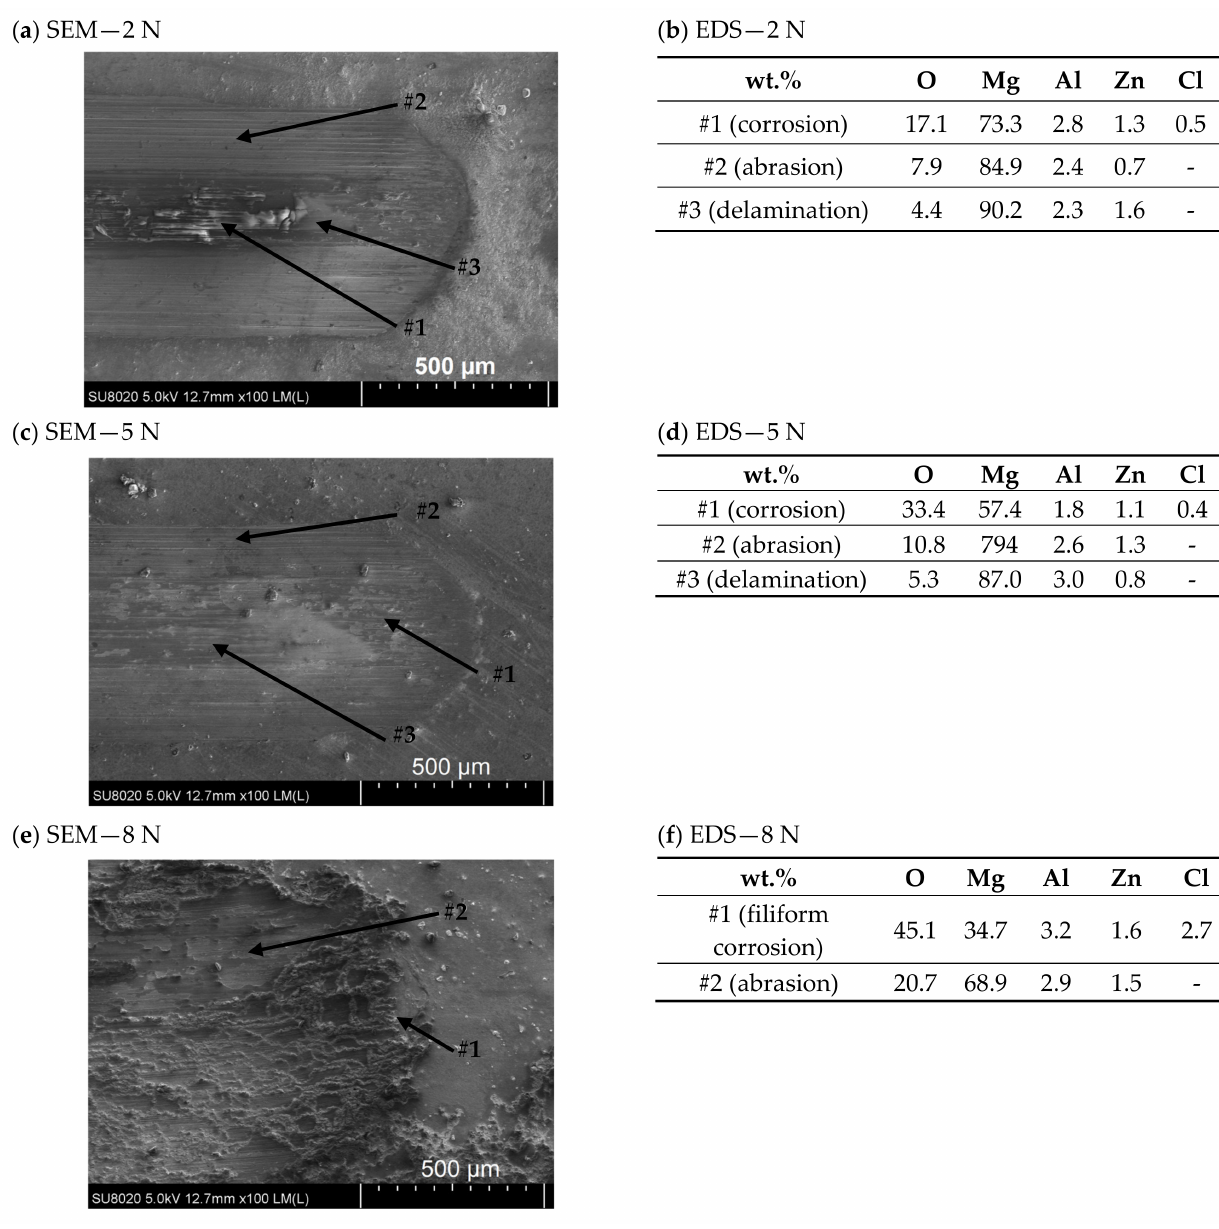
Figure 6. SEM and EDS analysis of AZ31 magnesium alloy in tribocorrosion: ( a ) SEM—2 N, ( b ) EDS— 2 N, ( c ) SEM—5 N, ( d ) EDS—5 N, ( e ) SEM—8 N, ( f ) EDS—8